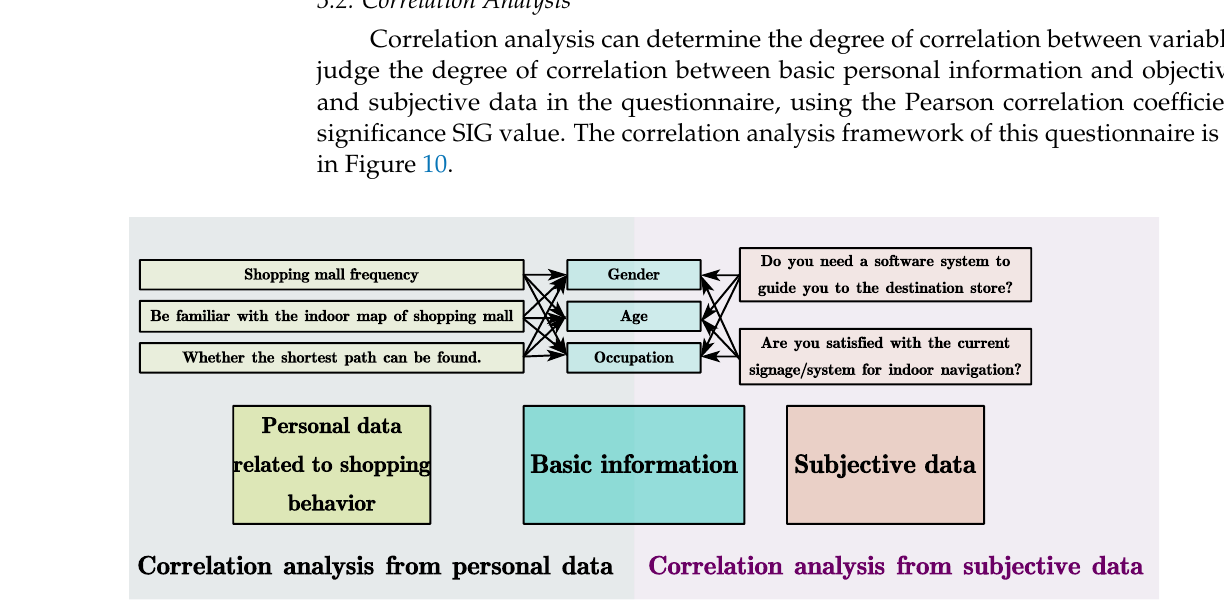
Figure 10. Framework for correlation analysis.